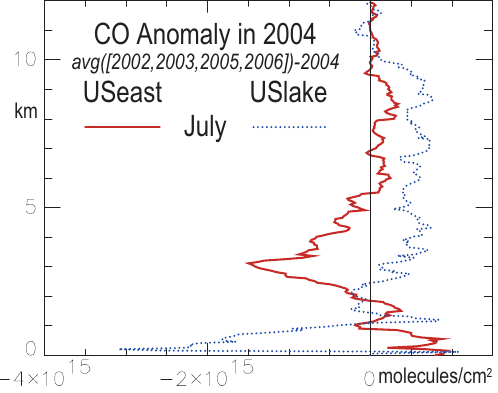
Fig. 7. Monthly mean tropospheric profiles of the CO July 2004 anomaly at USeast (red line) and USlake (dotted blue line) in moleculescm − 2